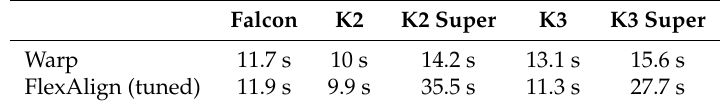
Table 6. Execution time on Testbed